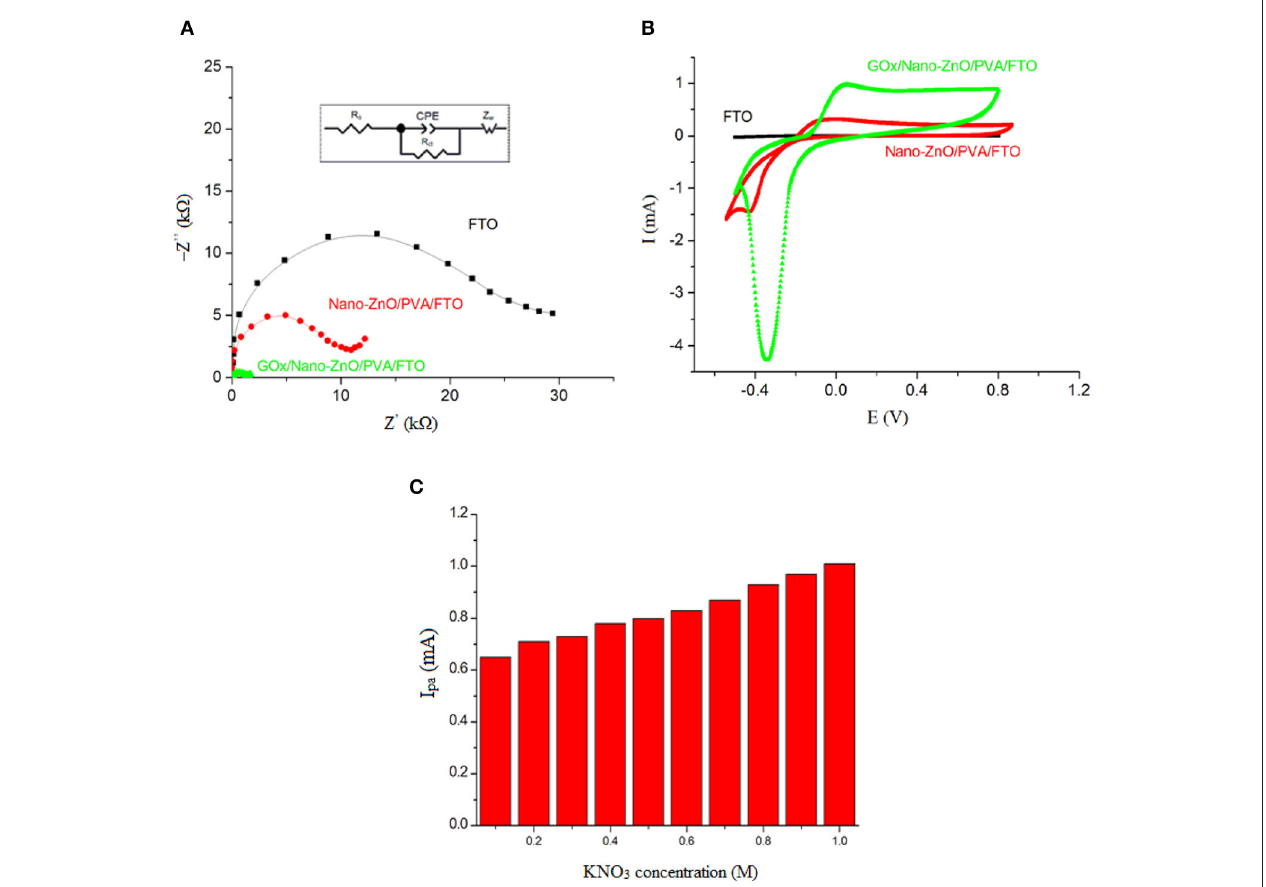
FIGURE 6 | (A) The Nyquist plots ( − Z ′′ vs. Z ′ ), and (B) Cyclic voltammograms at the scan rate of 0.1V s − 1 obtained in PBS (pH 7.4) containing 5 mM glucose in the absence of [Fe(CN)6]3 − /4 − probe, and (C) The influence of KNO3 salt concentration, as a supporting electrolyte, on the cyclic voltammogram electrochemical response of 5mM of glucose on GOx/Nano-ZnO/PVA/FTO biosensor. The inset in (A) shows equivalent circuit. (Zw: Warburg impedance, Ipa: anodic peak current, Rs: solution resistance, Rct: charge transfer resistance).